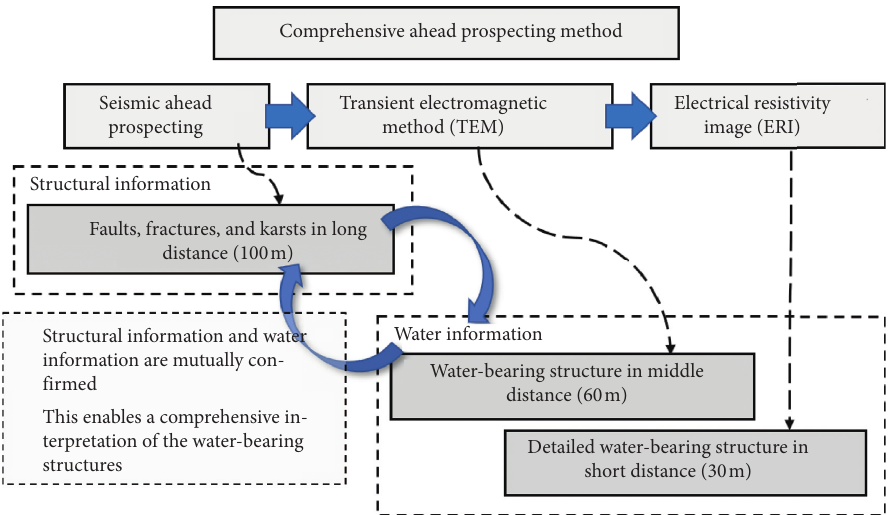
Figure 2: Process for comprehensive ahead prospecting.